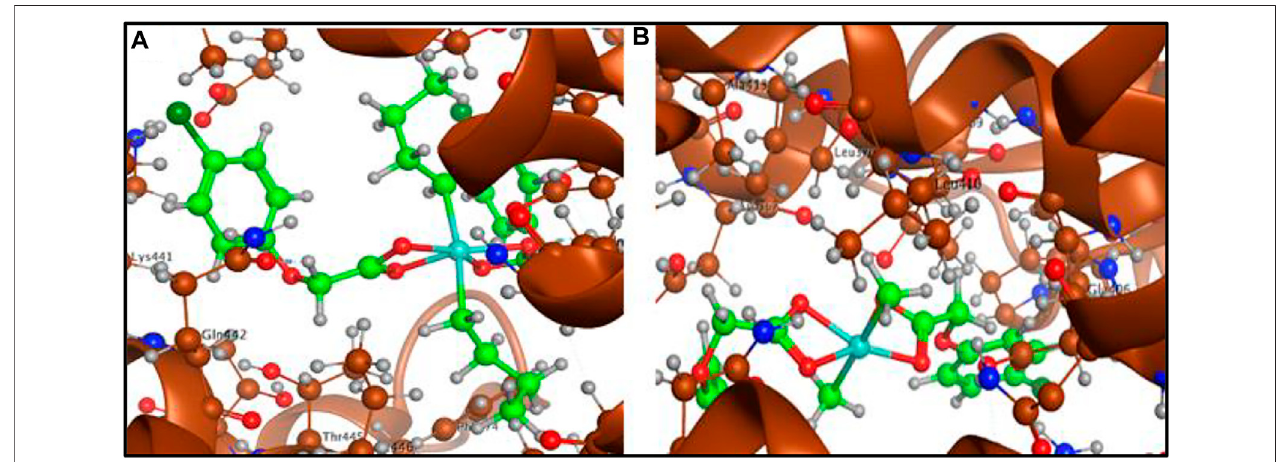
FIGURE 10 | (A) Complex 1 -angiotensin converting enzyme interaction and (B) Complex 2 -angiotensin converting enzyme interaction.